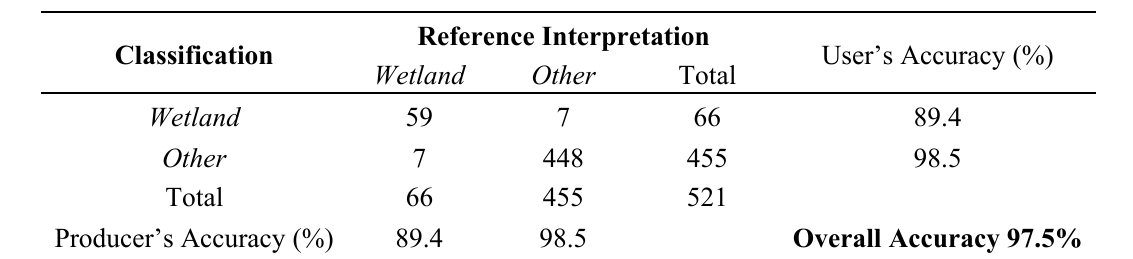
Table 3. Error matrix for wetland classification.